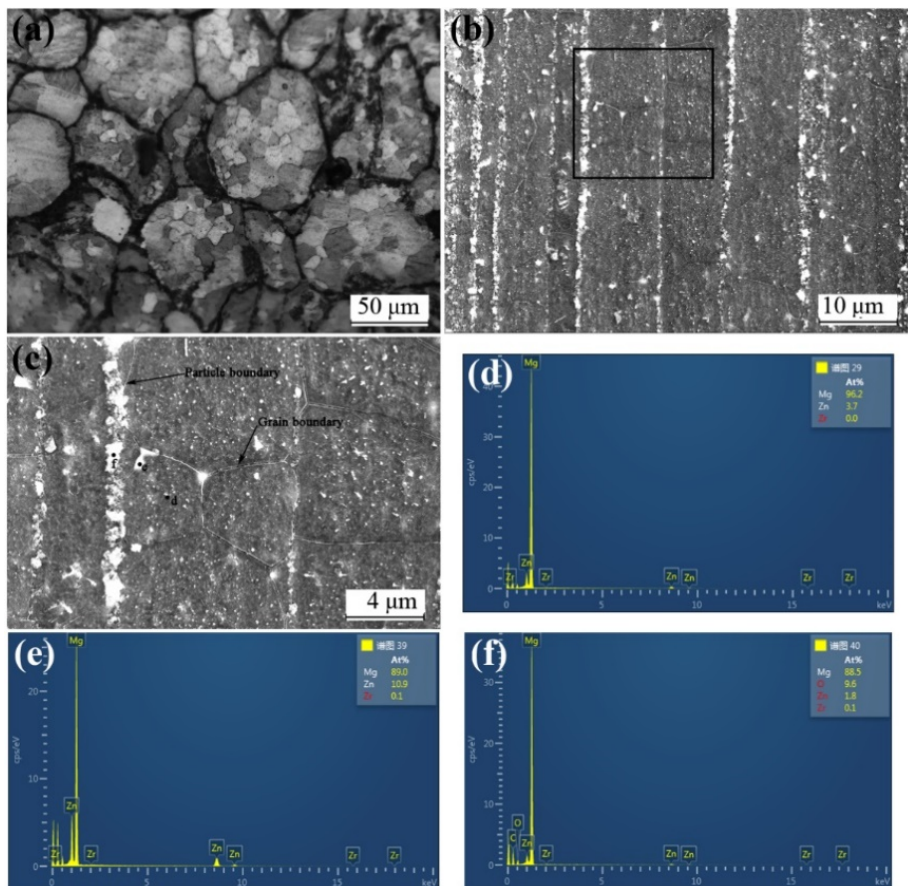
Figure 1. Microstructures of 0.05 wt.% ND/ZK60 composite: ( a ) OM image of as-sintered composite; ( b ) SEM image of as-extruded composite; ( c ) magnified view of the black rectangle area marked in ( b ); ( d ), ( e ), ( f ) are EDS spectra of points d, e, and f in ( c ), respectively.